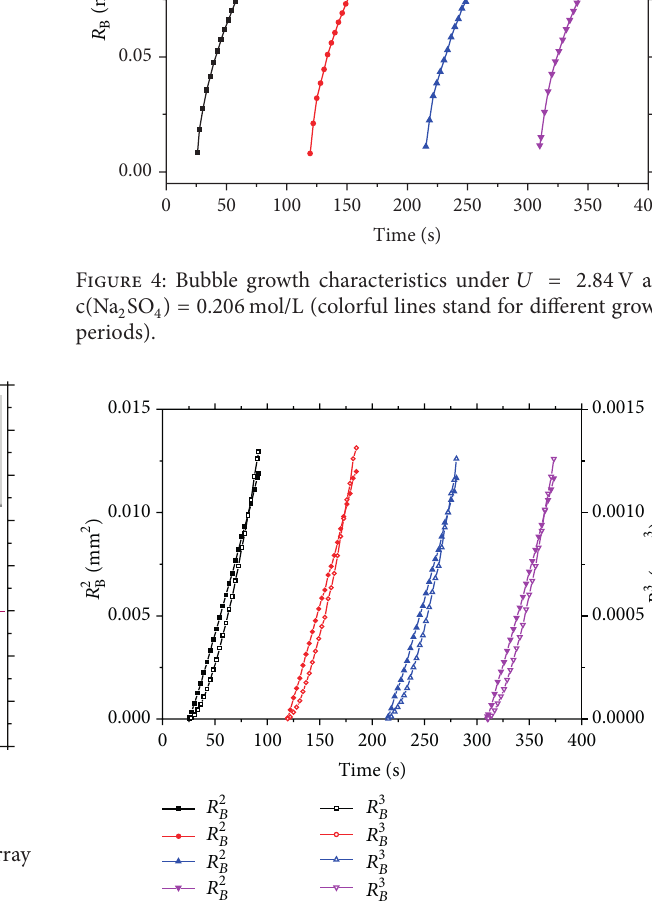
Figure 5: The relationship between bubble radius and time under 𝑈 = 2.84 V and c(Na 2 SO 4 ) = 0.206 mol/L (colorful lines stand for different growth